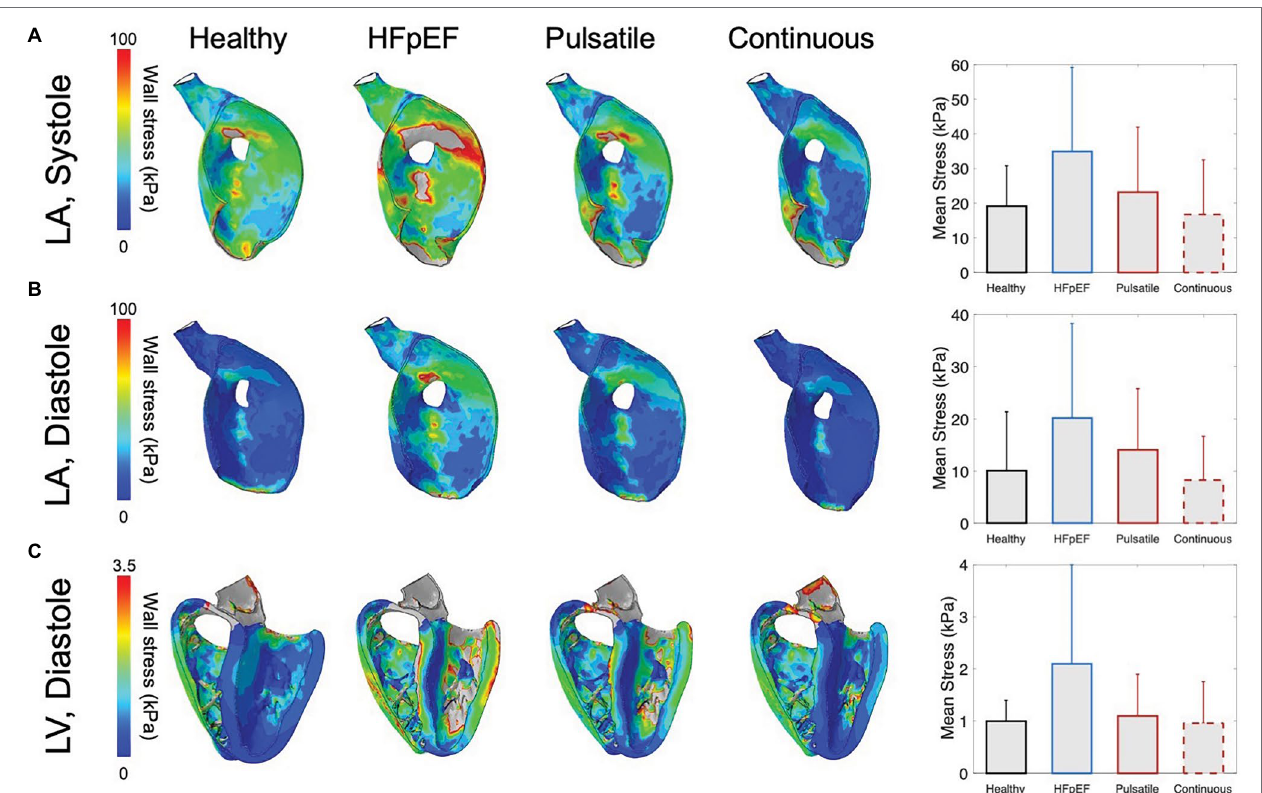
FIGURE 6 | Wall stress obtained by finite element analysis (FEA). Stress distribution of the left atrial (LA) wall (A) during systole and (B) diastole, and (C) of the left ventricular (LV) wall during diastole in the healthy heart, HFpEF, and under pulsatile and continuous support. The gray color in the contour plots represents the over values of the range (maximum color bar value). Bar charts illustrate corresponding mean stress values of active LV elements (~123,000 elements) during systole and diastole. Error bars indicate +1 standard deviation from the